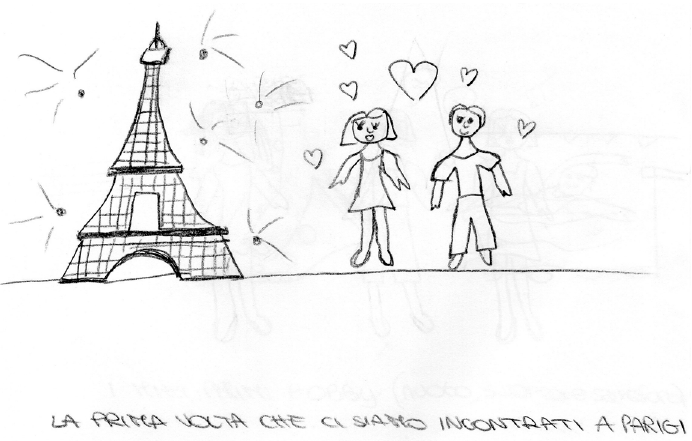
Figure 4. Drawing, referring to adolescence, entitled “The first time we met in